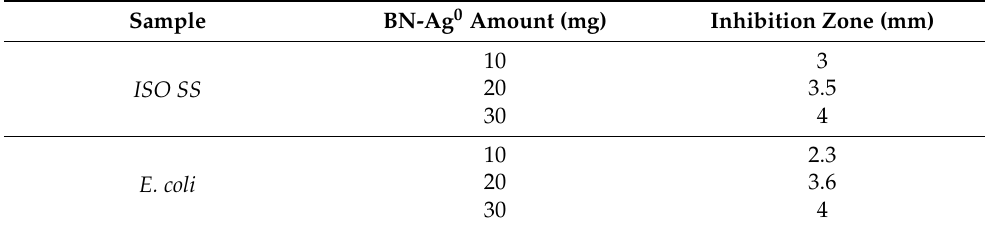
Figure 10. Inhibition zone revealing the antibacterial activity at 37 ˚ C of different BN-Ag 0 catalyst doses: 10 mg ( a ), 20 mg ( b ) and 30 mg ( c ), (in triplicate) for ISO SS strain. Table 7. Zone of inhibition (mm) of each sample (in triplicate) for ISO SS strain and E. coli. Sample BN-Ag 0 Amount (mg) Inhibition Zone (mm) ISO SS